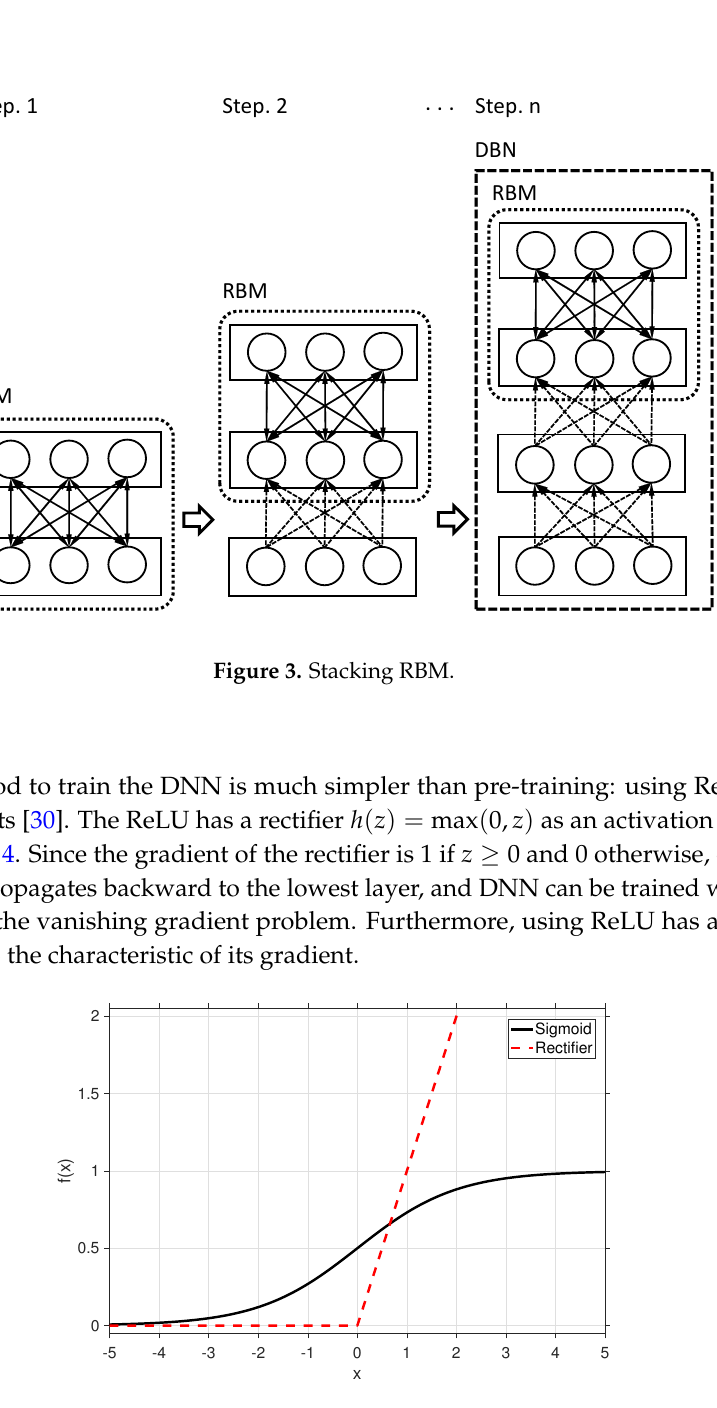
Figure 4. Activation